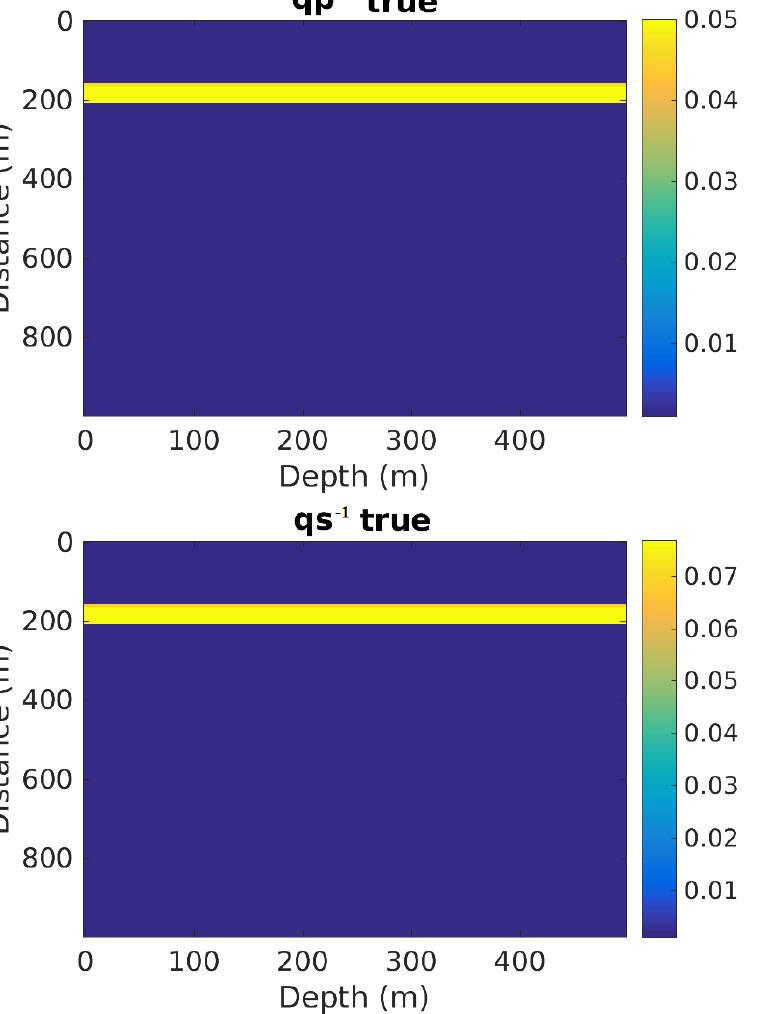
Figure 6. Q-factor distribution for P-( top ) and S-( bottom )